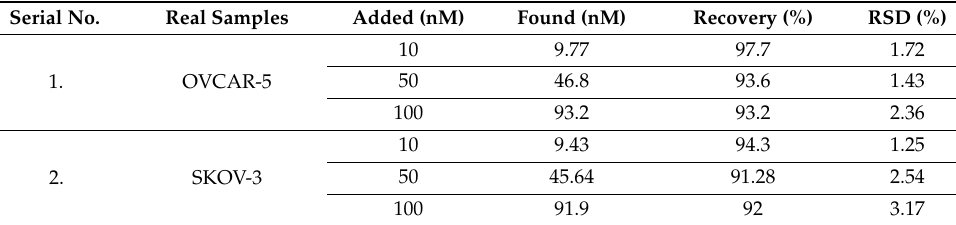
Figure 10. ( A ) The ORR on (curve i) bare GCE and (curve iii) FAD/Ti 3 C 2 T x /GCE in 0.1 M PBS with dissolved oxygen. Curve ii shows the CVs of the FAD/Ti 3 C 2 T x /GCE in N 2 saturated solution, scan rate = 50 mV/s. ( B , C ) The CVs were recorded for the analysis of spiked H 2 O 2 concentrations (10, 50 and 100 nM) in OVCAR-5 and SKOV-3 cancer cell lines samples using FAD/Ti 3 C 2 T x /GCE. Table 1. The FAD/Ti 3 C 2 T x modified electrode was used for the analysis of spiked H 2 O 2 in to OVCAR-5 and SKOV-3 cancer cell lines. Serial